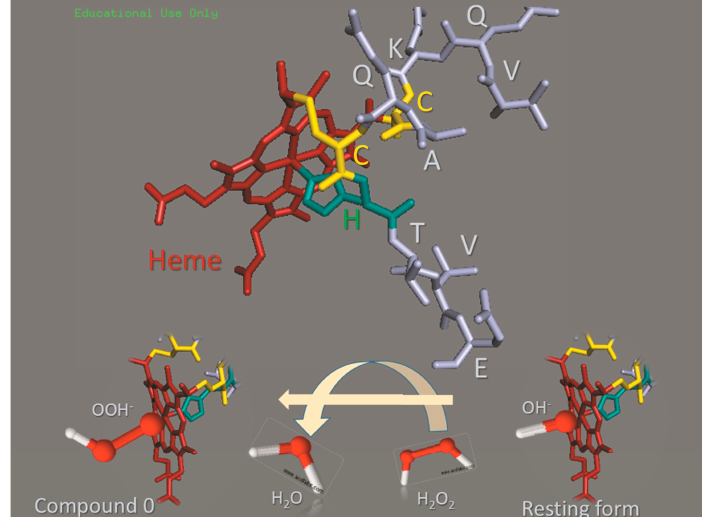
Figure 1. Cartoon of the microperoxidase structure. The upper side of the figure shows the MP-11 structure with the histidine side chain (blue) as a fifth axial ligand and the thioether bonds with cysteine residues (yellow) highlighted. The lower side of the figure represents the formation of Compound 0 by the replacement of water (OH − ) by a hydrogen peroxide molecule (HO-O − ) at the sixth axial position of heme iron. The microperoxidase structure was generated in the PyMol, 4.3 software by hiding part of Fe(III) horse heart cytochrome c structure available in Protein Data Bank (1HRC). Water and hydrogen peroxide molecules were designed using 3D representation in ChemSketch 2016.1 (free version for educational use